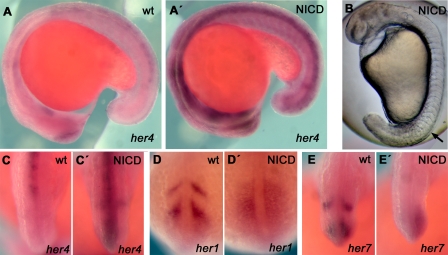
Overactivation of the Notch Pathway by NICD Causes Somite Boundary Defects After a Long DelayNICD overexpression was induced by 30-min heat shock in hsp70:Gal4VP16;UAS:myc-notch1aICD transgenic embryos.(A,A′) One hour after the end of a heat shock (delivered at the 16-somite stage), her4 expression is strongly induced in the neural tube and other tissues, including the PSM (C,C′).(B) An embryo heat-shocked at 10 hpf, showing disturbances of somite boundary formation only after a long delay (as with DAPT treatment). The start of the boundary defects is marked by the arrow.(D,D′) Embryos heat-shocked at the five-somite stage, fixed 2.5 h later, and stained by ISH for her1.(E,E′) Embryos heat-shocked at the 16-somite stage, fixed 3 h later, and stained by ISH for her7. For both her1 and her7, the stripy pattern seen in the controls is replaced by more uniform expression in the transgenic embryos, implying a breakdown of synchronized oscillation. Note that the levels of her1 and her7 expression in the transgenic embryos are lower than the peak levels in the normal controls. For each case in (A) to (E), at least 14 embryos were examined and typical specimens were selected for this illustration.